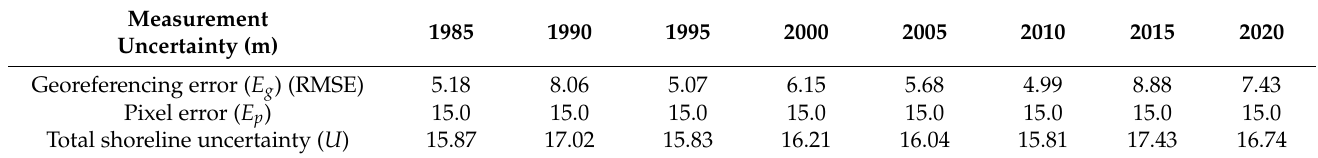
Table 4. Estimated total shoreline uncertainty for each of the Landsat